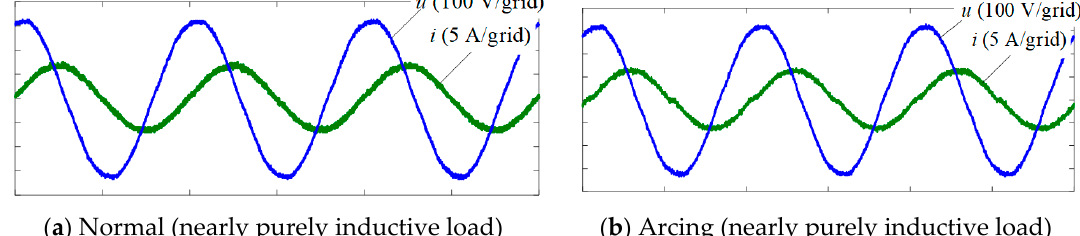
Figure 8. Resistance–inductance load.